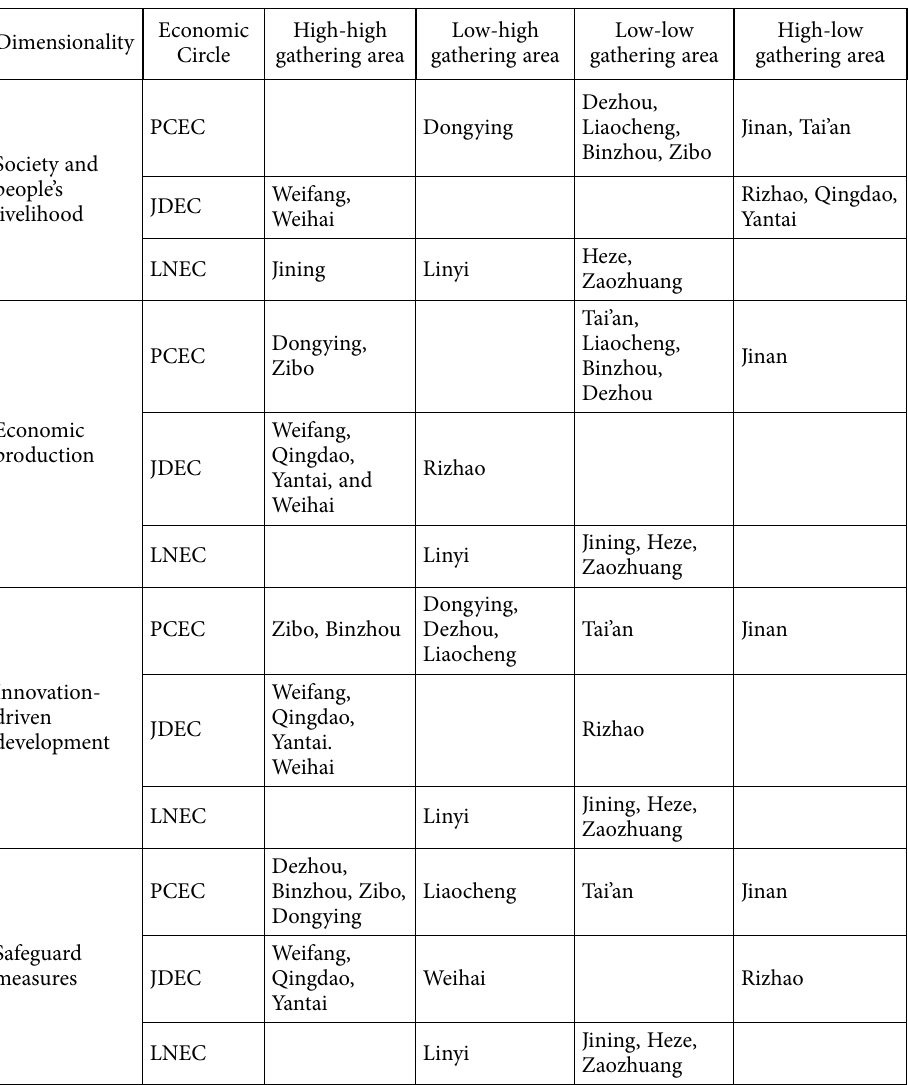
Table 4. Regional clustering of SCCs’ construction level by dimension